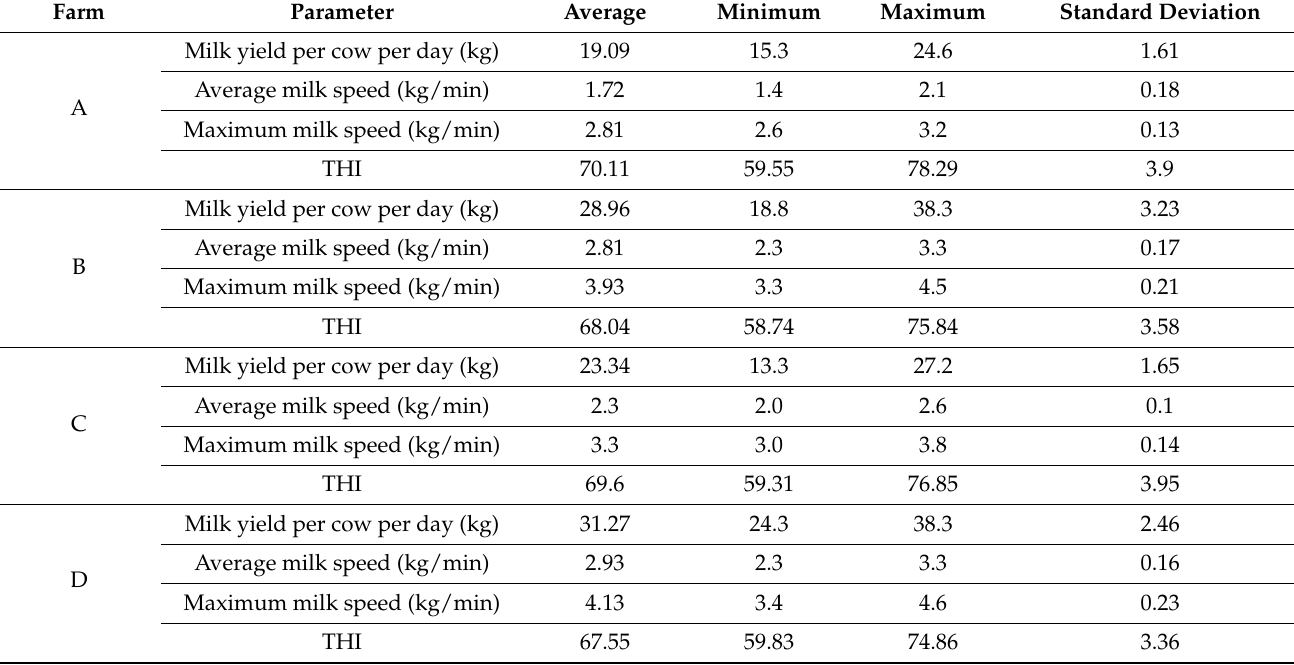
Table 5. Results of the descriptive statistics of all four